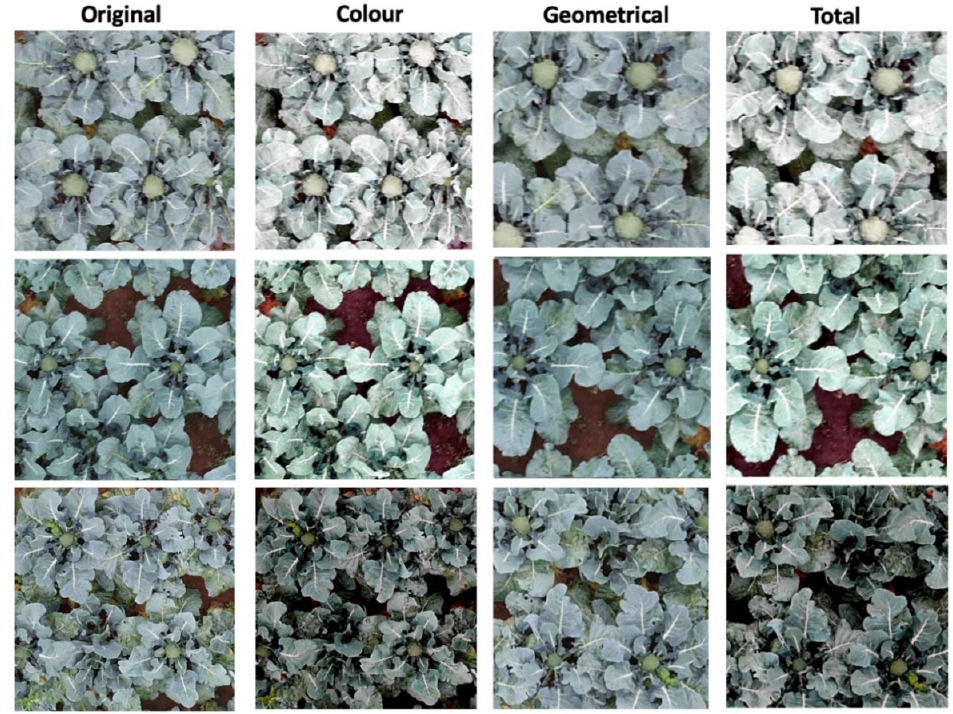
Figure 7. Example of the original images, and after applying the augmentation transformations.